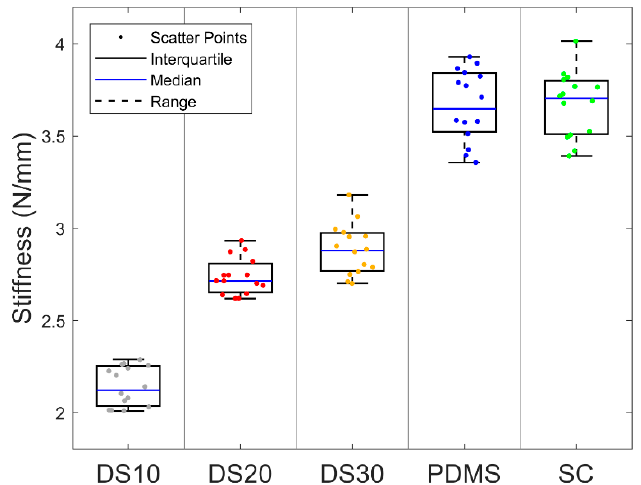
Figure 2. Mechanical characterization of the phantom: scatter points are the stiffness values collected for each material (Dragon Skin 10—DS10; Dragon Skin 20—DS20; Dragon Skin 30—DS30; polydimethylsiloxane—PDMS; Sorta Clear 40—SC) across the five trials of indentation; boxes represent interquartile ranges for the five materials; blue lines show the median values and black dashed lines the full ranges among the measured values.